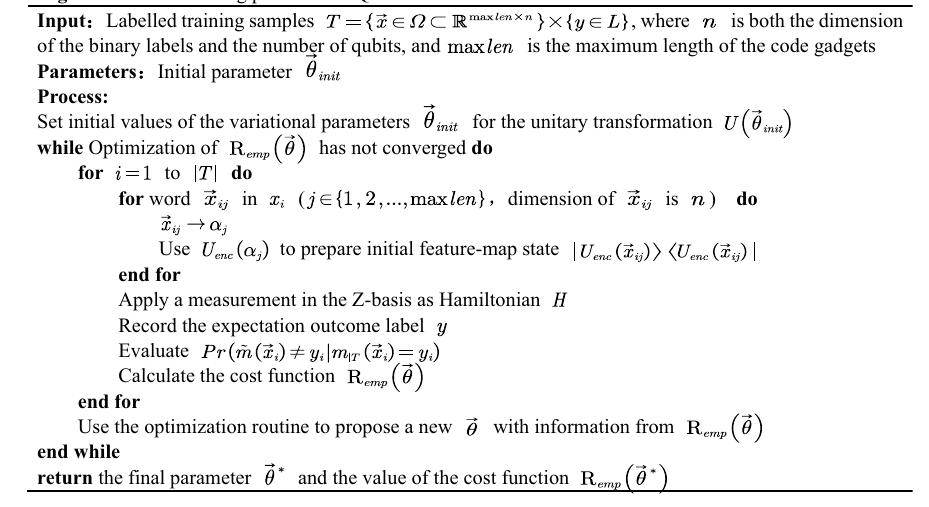
Algorithm 1 The training phase of the QDENN